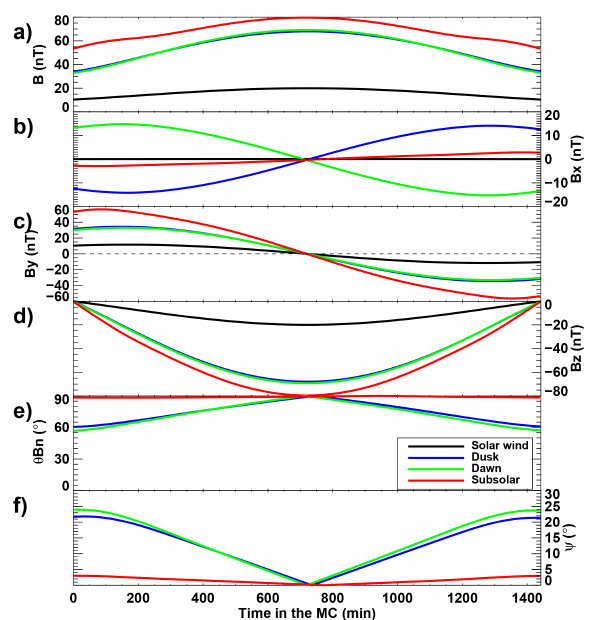
Fig. 6. Virtual spacecraft observations of the magnetosheath mag- netic field during an MC with its axis along z . Solar wind inputs (black) – spacecraft: in the subsolar magnetosheath (red), on the dusk flank (blue), on the dawn flank (green) – from top to bottom: magnetic field magnitude, B x , B y and B z components, 2 Bn values at the origin of the flowline and ψ angle between the magnetic field vectors in the solar wind and in the